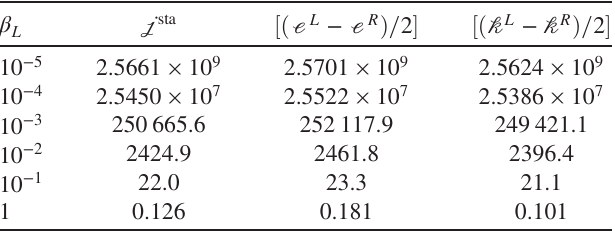
TABLE I. The functions j sta , ½ð e L − e R Þ = 2 (cid:3) , and